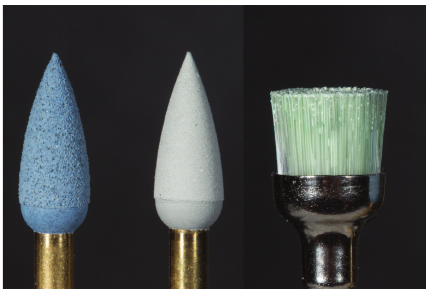
Figure 10: Instruments and material for the mirror finish of the